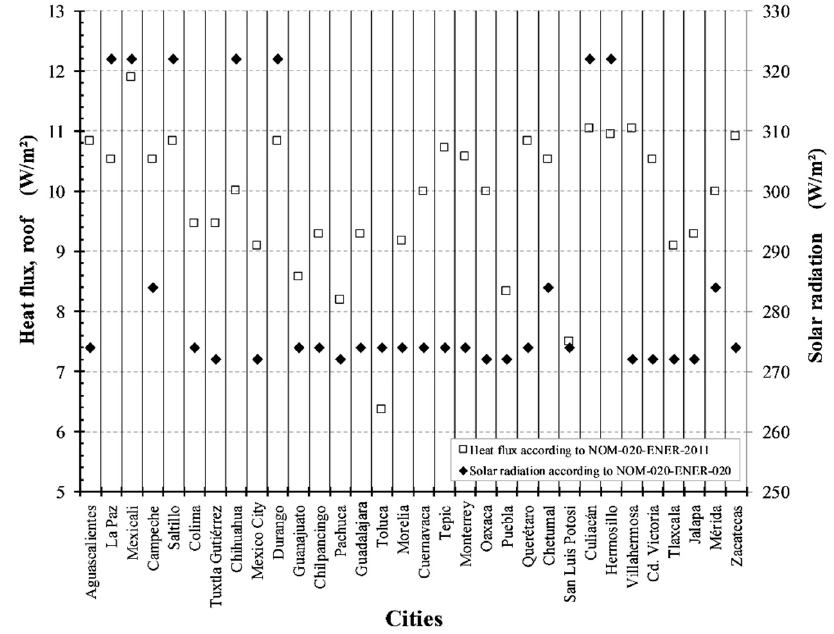
Figure 1. Calculated heat flux and assigned solar radiation for Mexican capital cities.